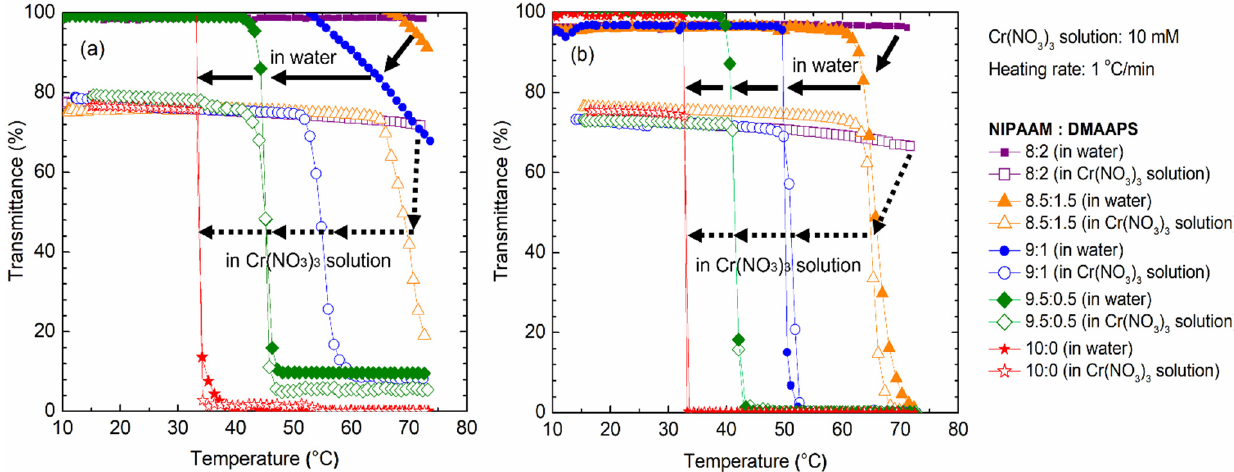
Figure 3. Phase transition temperature of poly(NIPAAM- co -DMAAPS) at polymer concentration of ( a ) 1 g/L and ( b ) 10 g/L. Heating rate = 1 °C/min in water and Cr(NO 3 ) 3 solution.